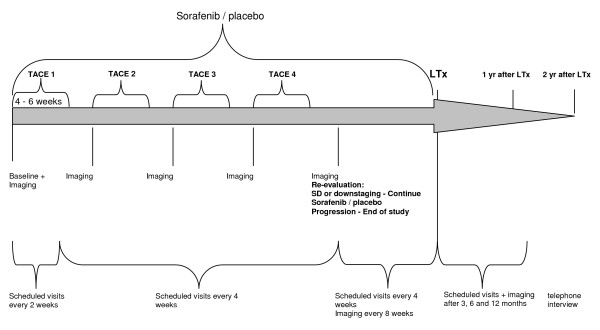
Treatment schedule.